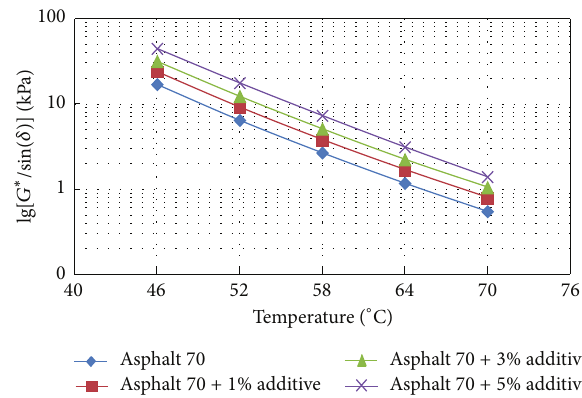
Figure 3: 𝐺 ∗ of 90# virgin asphalt and WMA binder versus temper- ature.